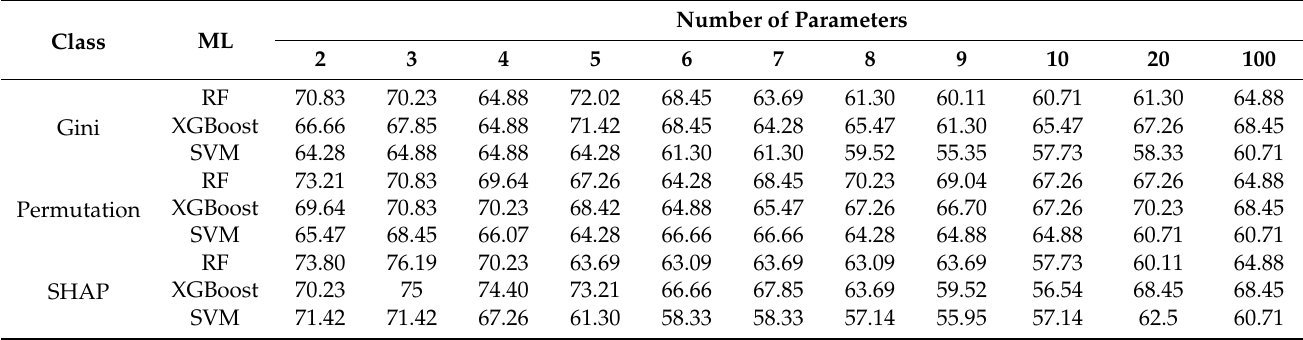
Table 7. Osteopenia identification results according to the number of important parameters (accu- racy,